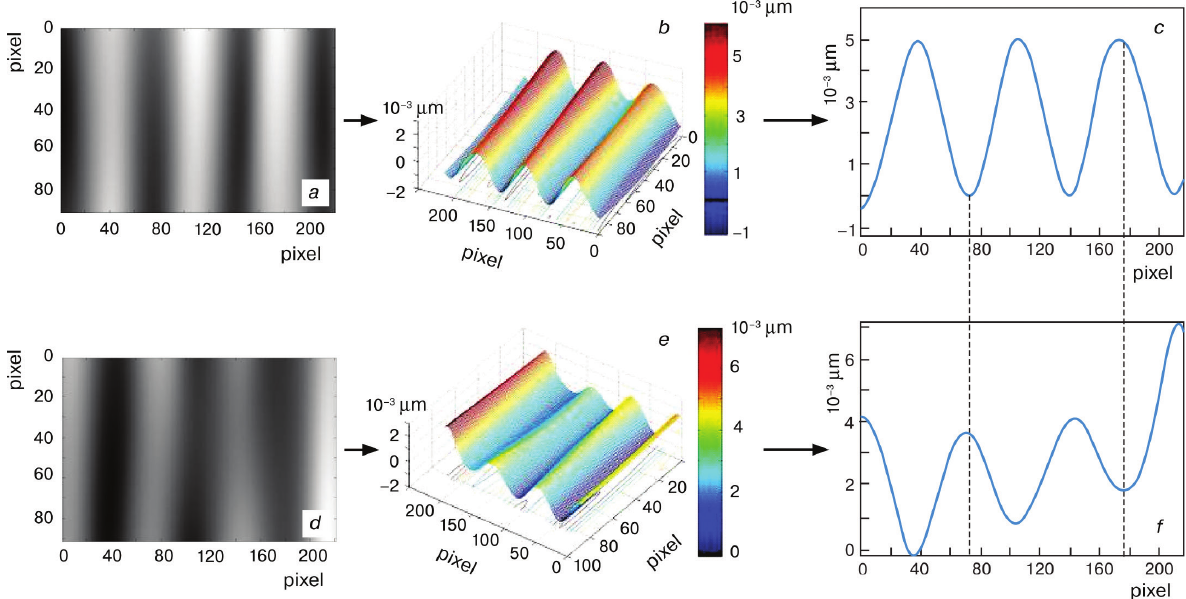
Figure 6. SAW type check in SC mode by comparing surface motion functions for a specimen area at different arbitrary moments of time: ( a and d ) interference patterns, ( b and e ) restored motion field and ( c and f ) vertical section of restored motion field. Recording instant for the top figures differs from that for the bottom figures by an arbitrary